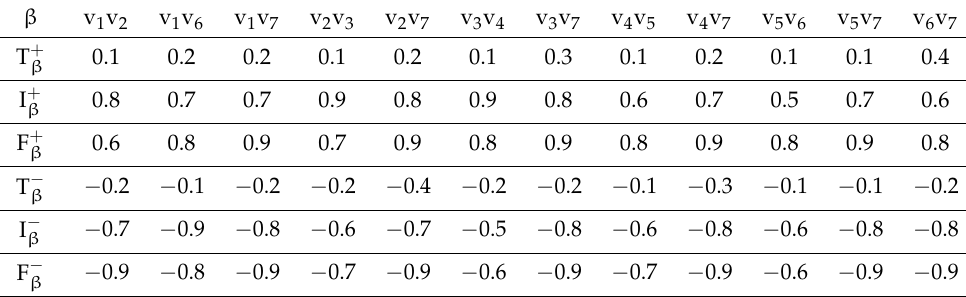
Table 5. Laplacian energy of BSVNG relation on